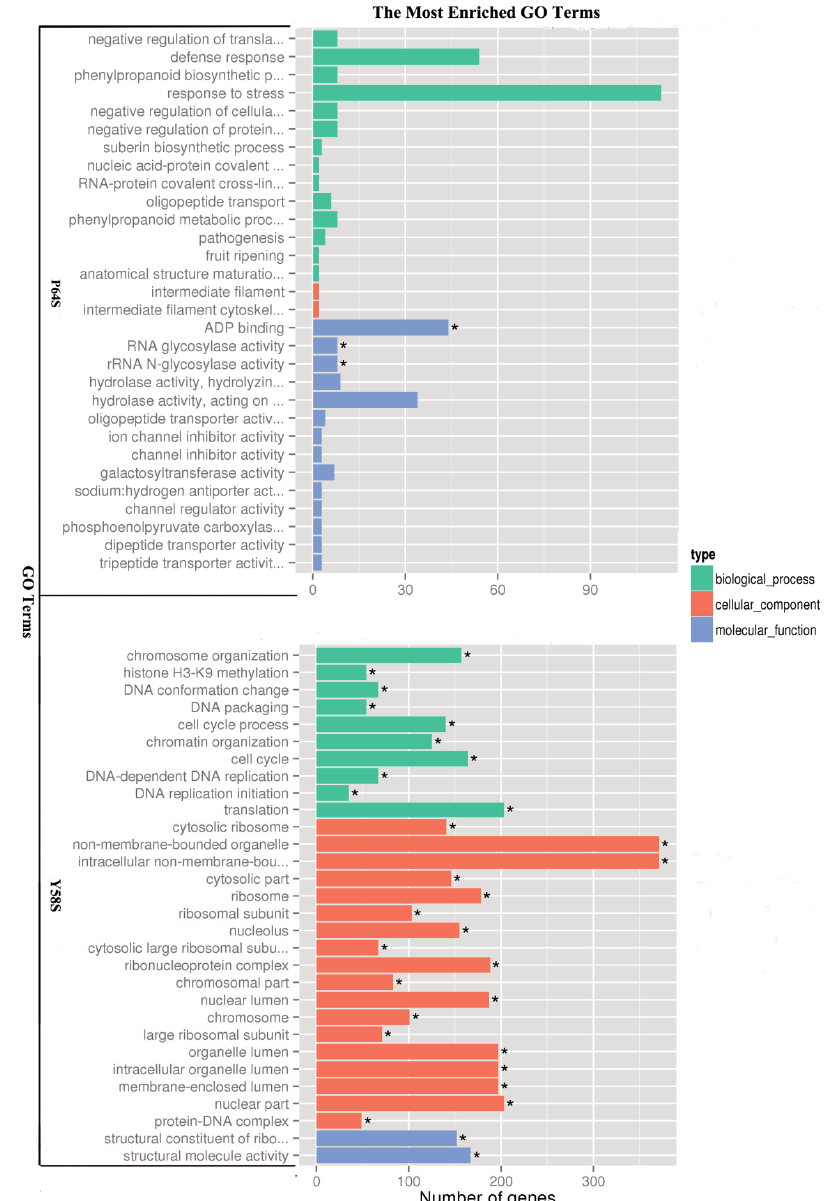
Figure 3. Gene ontology (GO) classifications of differentially expressed genes (DEGs) in P64S and Y58S, respectively. * indicates significantly enriched GO terms with correct p -value <